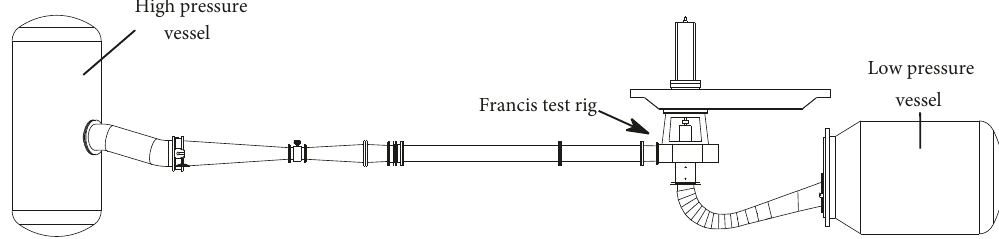
Figure 1: The Francis test-rig, including the high and low pressure vessels. The figure is reproduced from Agnalt et al. 2018 [12].